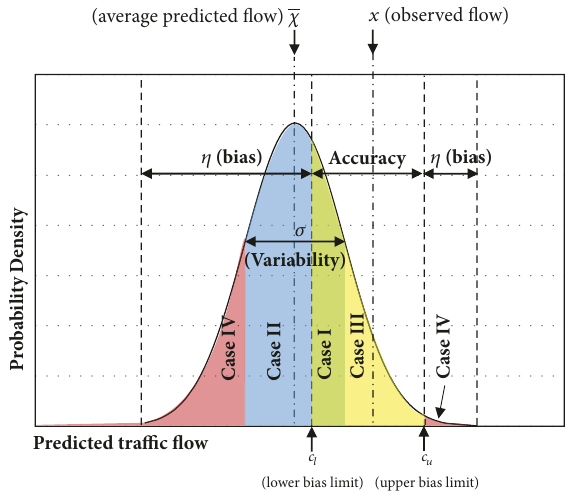
Figure4:Theprobabilitydensityofpredictedtrafficflowsaddressed with the uncertainty cases.